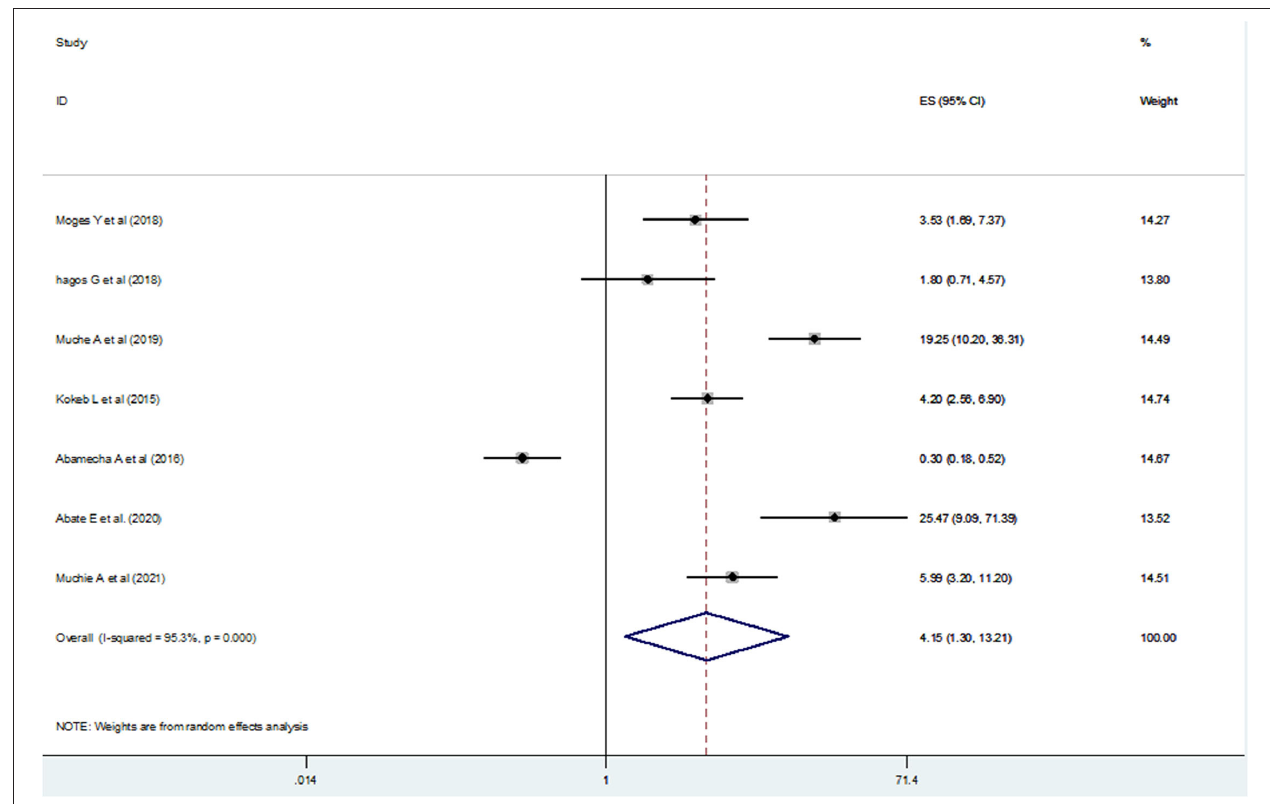
FIGURE 7 | The pooled odds ratio of the association between post-abortion contraceptive counseling and post-abortion contraceptive utilization in Ethiopia, 2021.